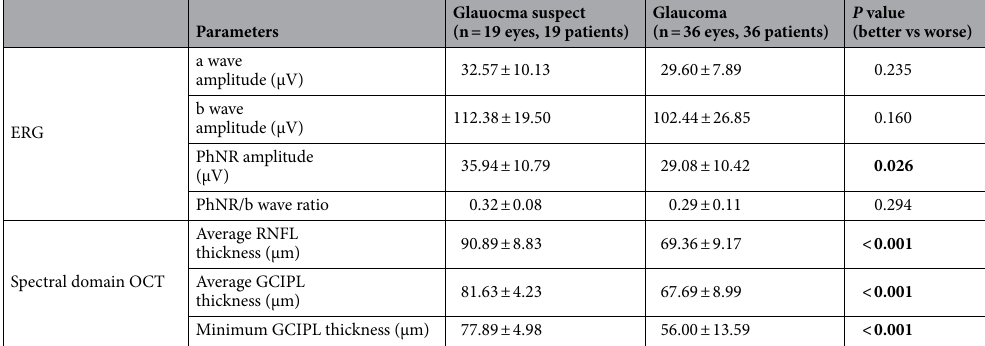
Table 2. Electroretinograms, retinal nerve fiber layer (RNFL) thickness, and ganglion cell-inner plexiform layer (GCIPL) thickness in patients with glaucoma or suspected glaucoma. ERG, electroretinogram; GCIPL, Ganglion cell-inner plexiform layer; OCT, optical coherence tomography; RNFL, retinal nerve fiber layer. *Statistically significant differences between two groups ( P < 0.05) by student’s t-test are indicated in bold.